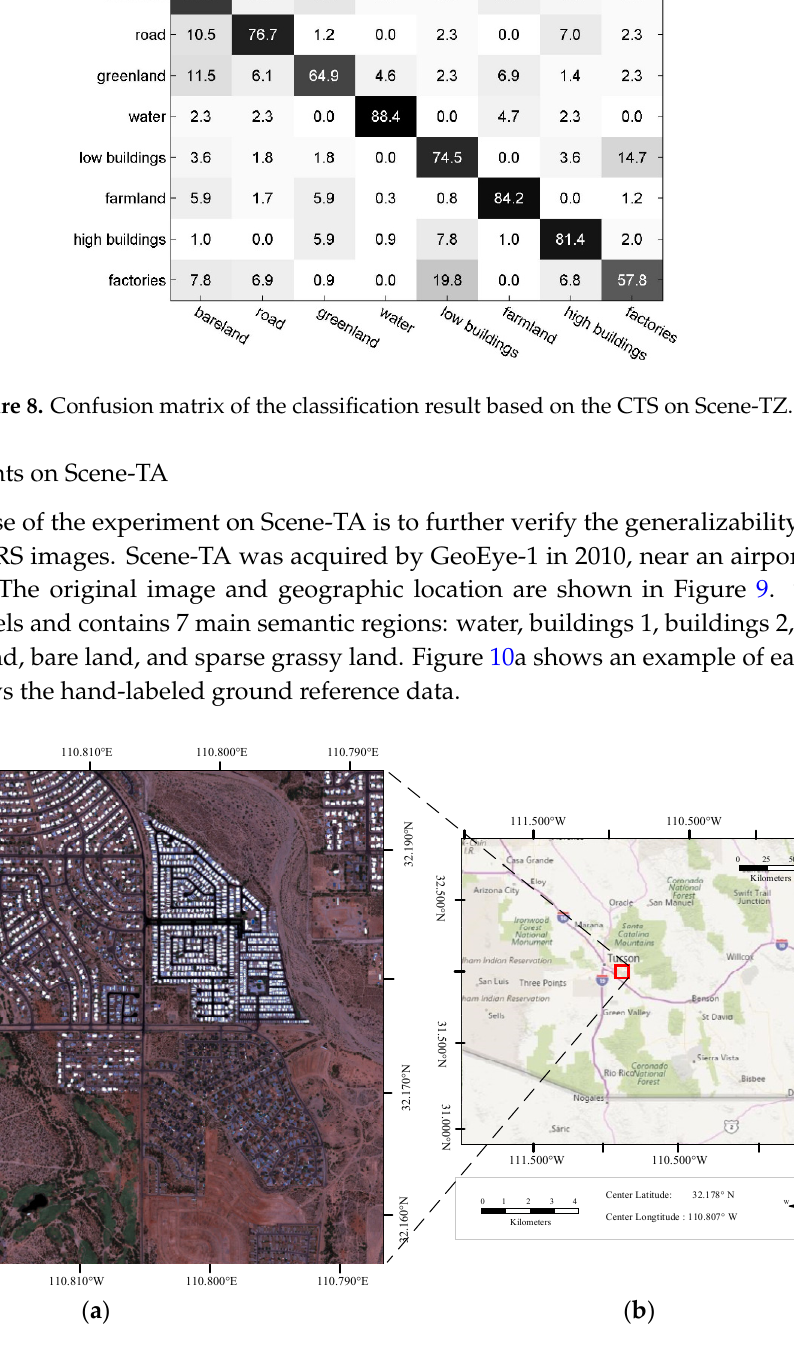
Table 7. Classification accuracy comparison on Scene-TZ with ten training samples per class.